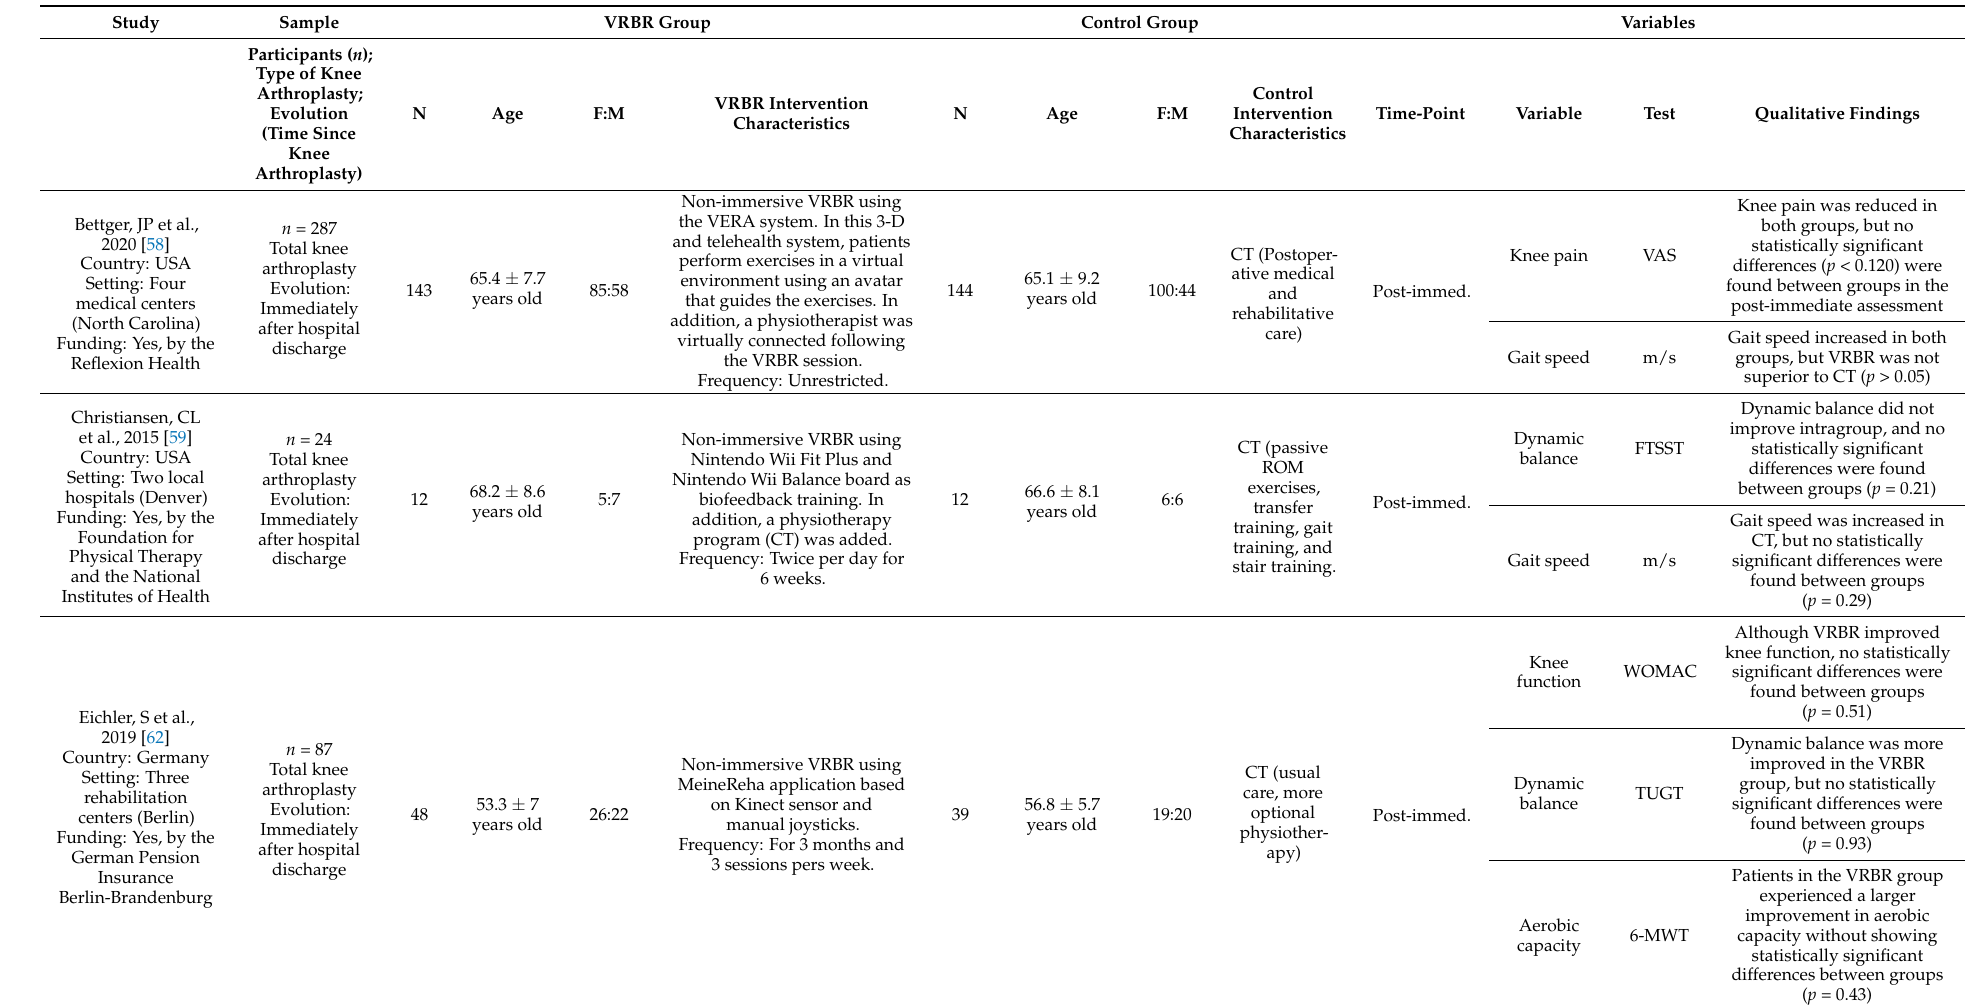
Table 2. Main characteristics of the studies included in the